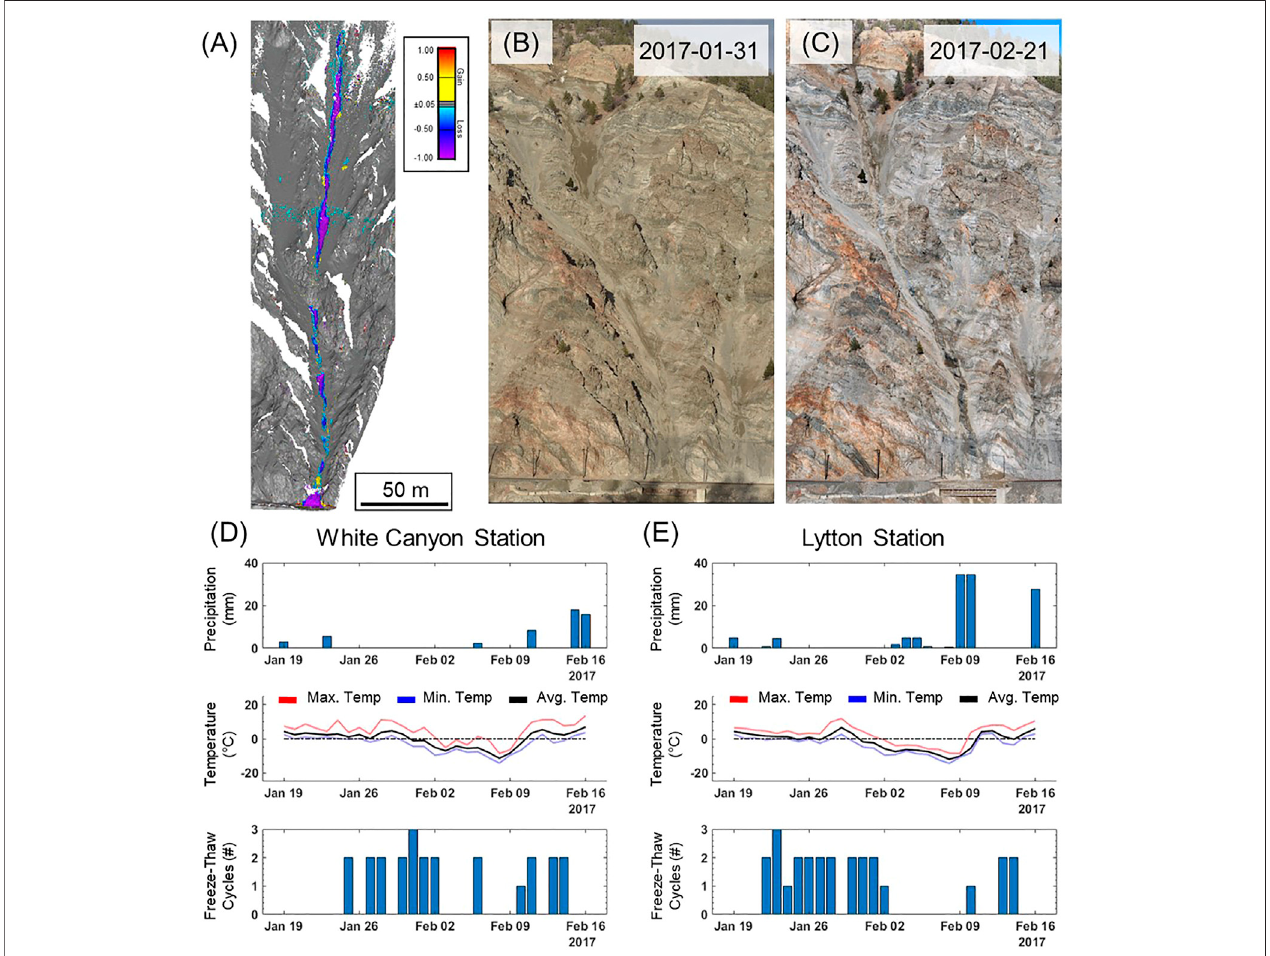
FIGURE 15 | Overview of the 16 February 2017 debris- fl ow in WCE. (A) M3C2 change detection between scans captured on 31 January 2017 and 21 February 2017.Panoramicimages ofthechannelcaptured on (B) 31January2017and (C) 21February 2017.Climatesignaturesleadinguptothedebris- fl ow (D) WhiteCanyon weather station and (E) Lytton weather